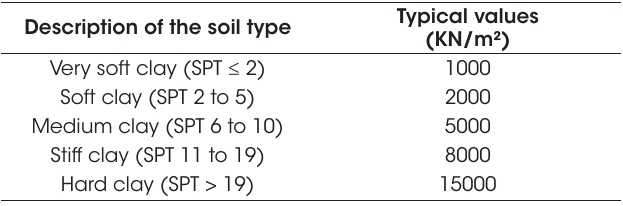
Soil deformation modulus